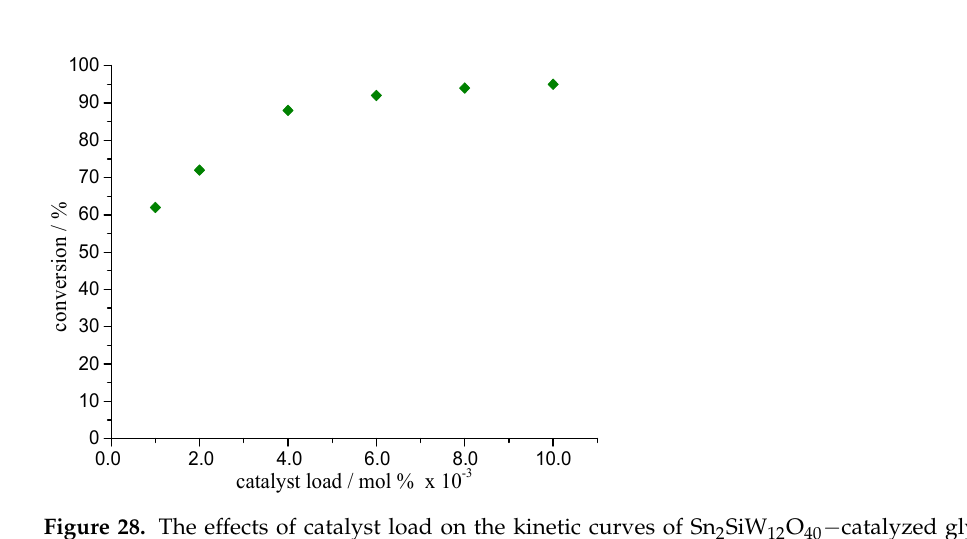
Figure 28. The effects of catalyst load on the kinetic curves of Sn 2 SiW 12 O 40 − catalyzed glycerol condensation with acetone (adapted from ref. [72]. Reaction conditions: glycerol: acetone (1:12); volume (10 mL); Sn 2 SiW 12 O 40 catalyst (variable); 298 K.